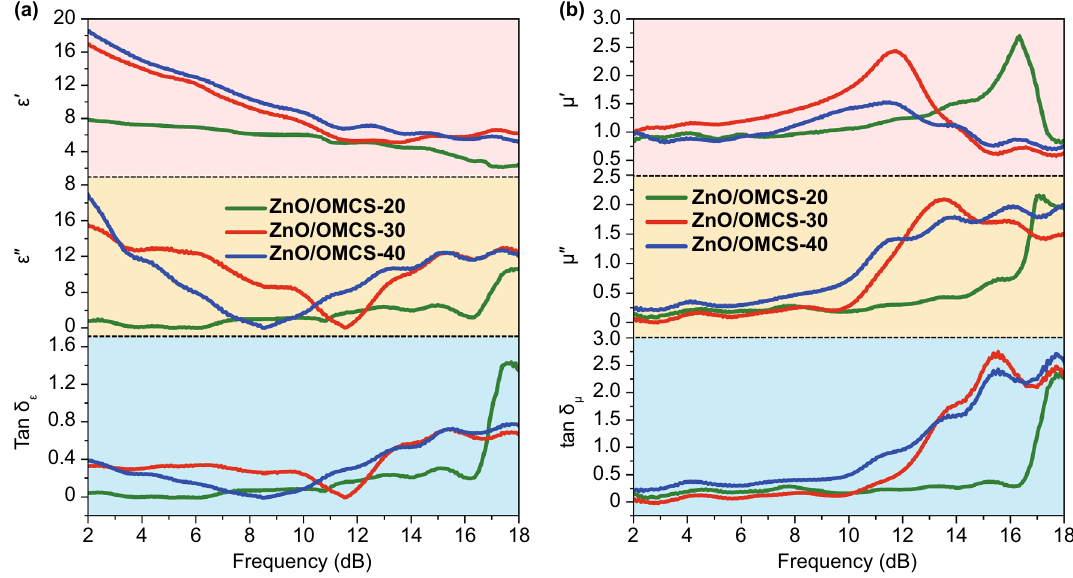
Fig. 5 Frequency dependence of a real part of permittivity, imaginary part of permittivity and tangent dielectric loss values of ZnO/OMCS- 20, ZnO/OMCS-30 and ZnO/OMCS-40 b real parts of permeability, imaginary part of permeability and tangent magnetic loss values of ZnO/ OMCS-20, ZnO/OMCS-30 and